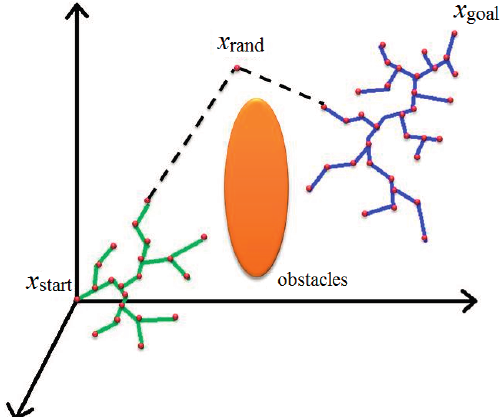
Figure 3. Random node connecting two random